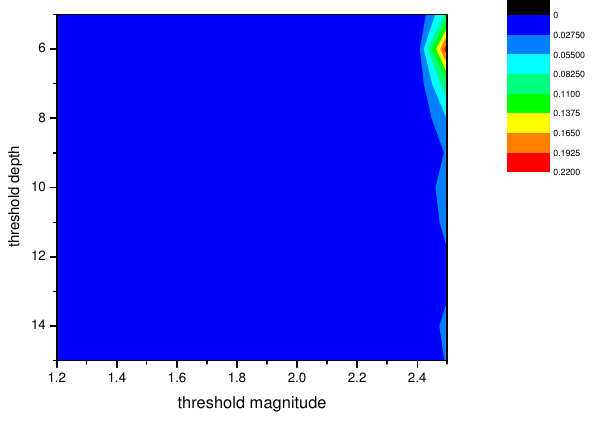
Fig. 9. DFA results for the interdistance time series shown in Fig. 13.